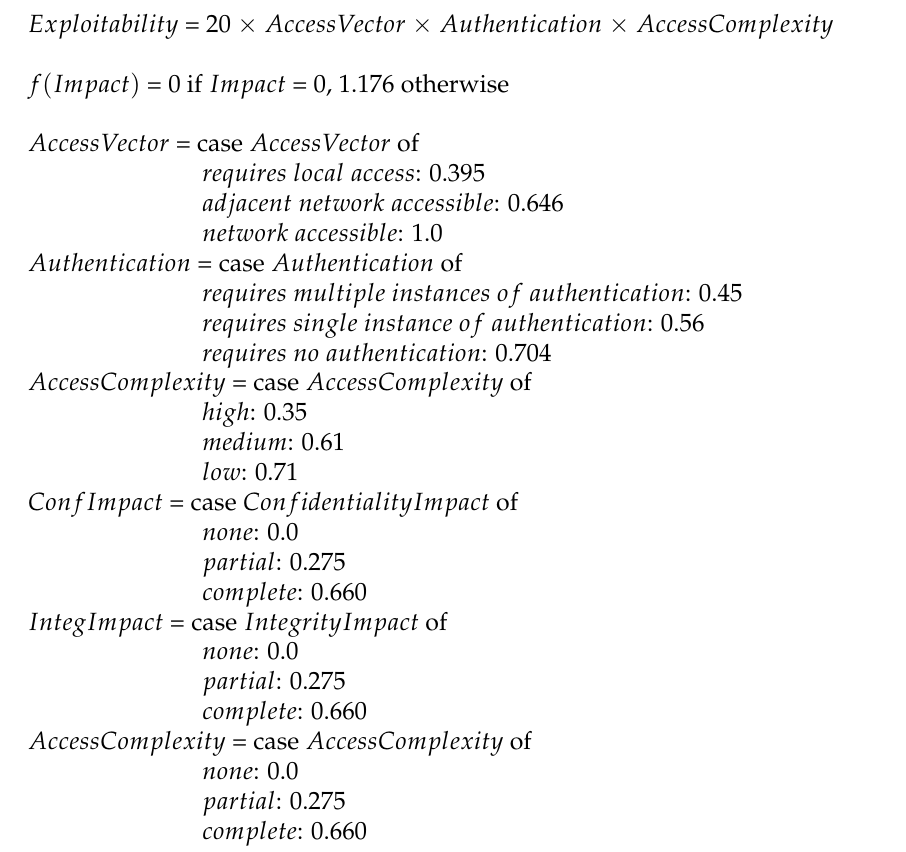
Algorithm 1 Base score